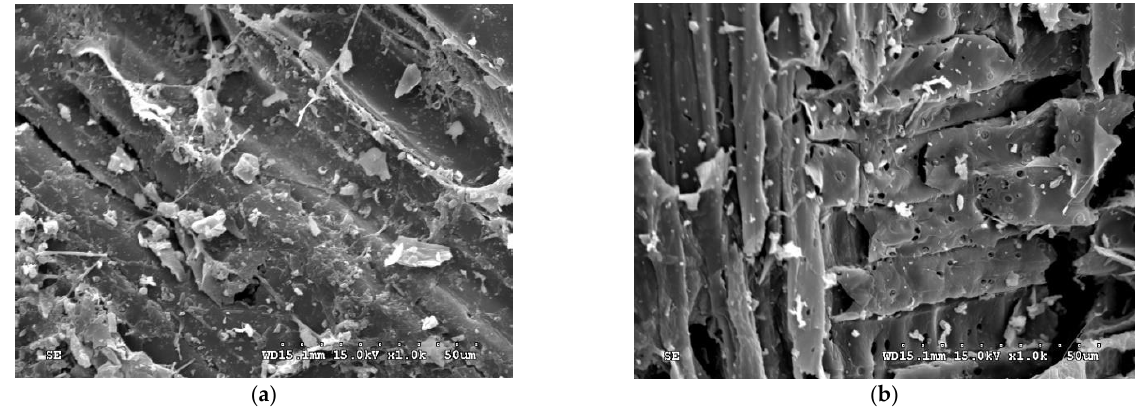
Figure 5. SEM images (×1000, right) of the biochar products for ( a ) SMC-SF and ( b ) SMC-SF-BC-800.